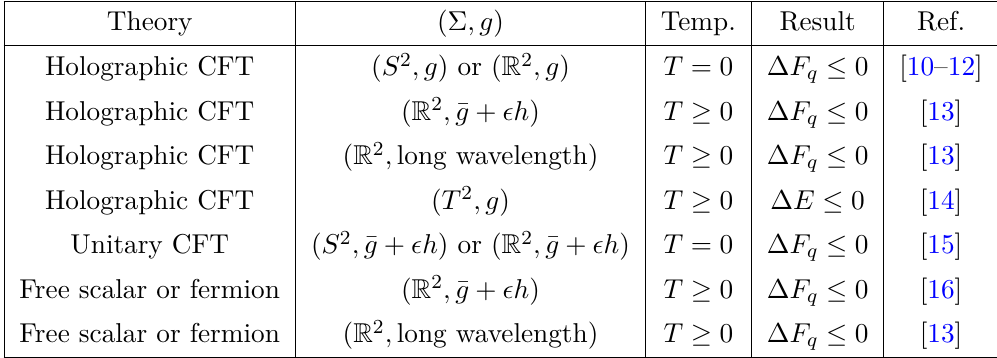
Table 1. A summary of results for the free energy F q (or just energy E in the fourth row) for various types QFTs at various temperatures. “Holographic CFTs” refer to CFTs dual to smooth geometries obeying Einstein’s equations; the scalar refers to a scalar field of any mass and curvature coupling; and the fermion refers to a Dirac fermion of any mass. ¯ g is always taken to be the maximally symmetric geometry on the manifold Σ (so ¯ g is the round sphere metric when Σ = S 2 and the flat metric when Σ = R 2 or T 2 ), and when we write ¯ g + (cid:15)h it is understood that the result holds to leading nontrivial order in the perturbative expansion parameter (cid:15) . “Long wavelength” refers to metrics whose curvature is small compared to the temperature and/or mass of the field. All inequalities on ∆ F q and ∆ E are saturated if and only if g = ¯ g